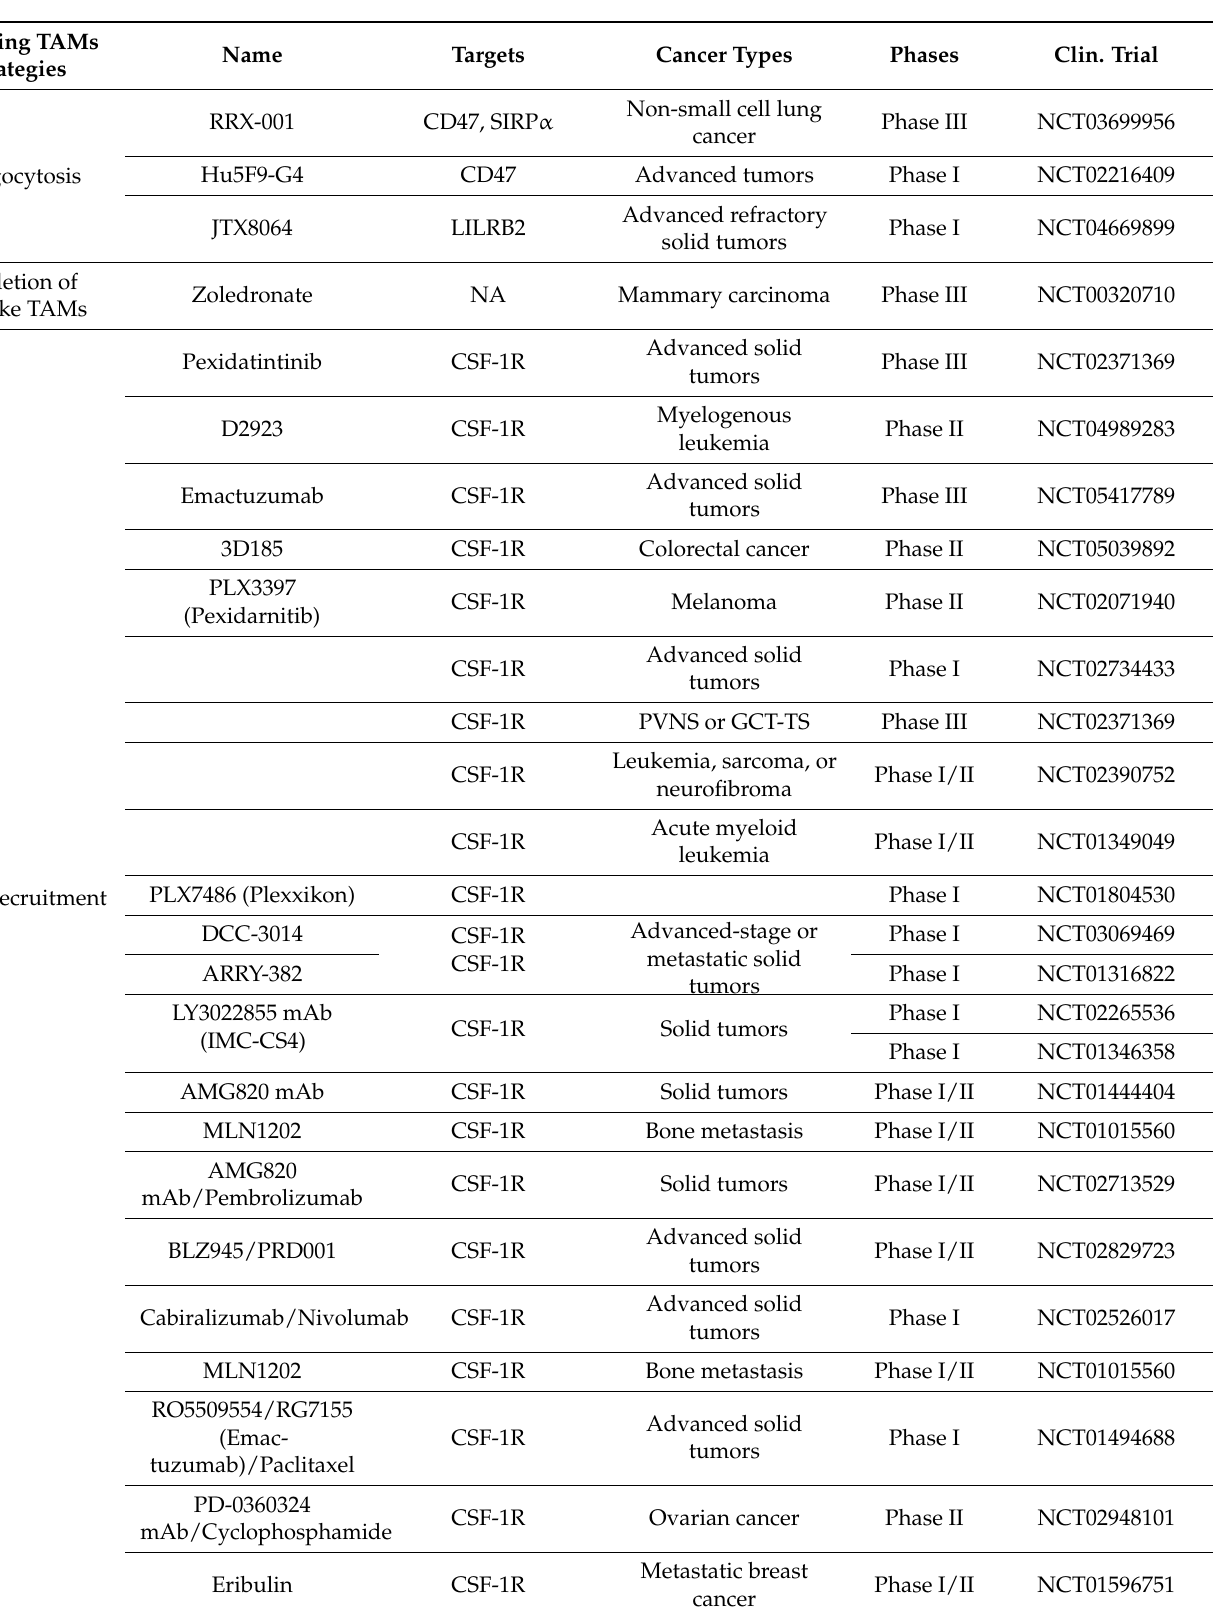
Table 1. Selected clinical trials of TAM-targeting